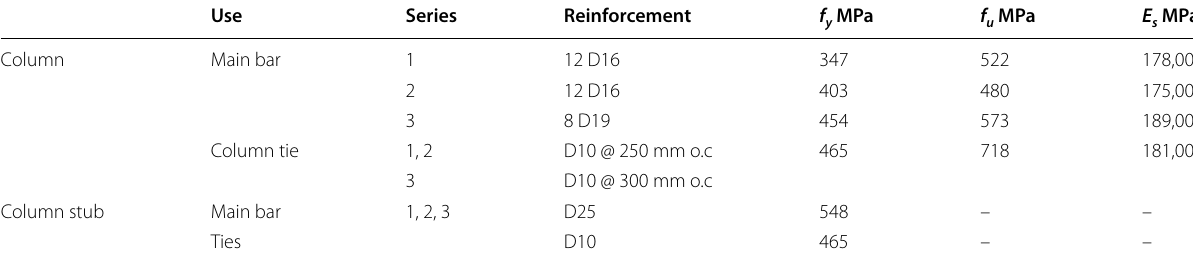
f y is specified yield strength of reinforcement; f u is tensile strength of reinforcement; E s is young’s modulus of